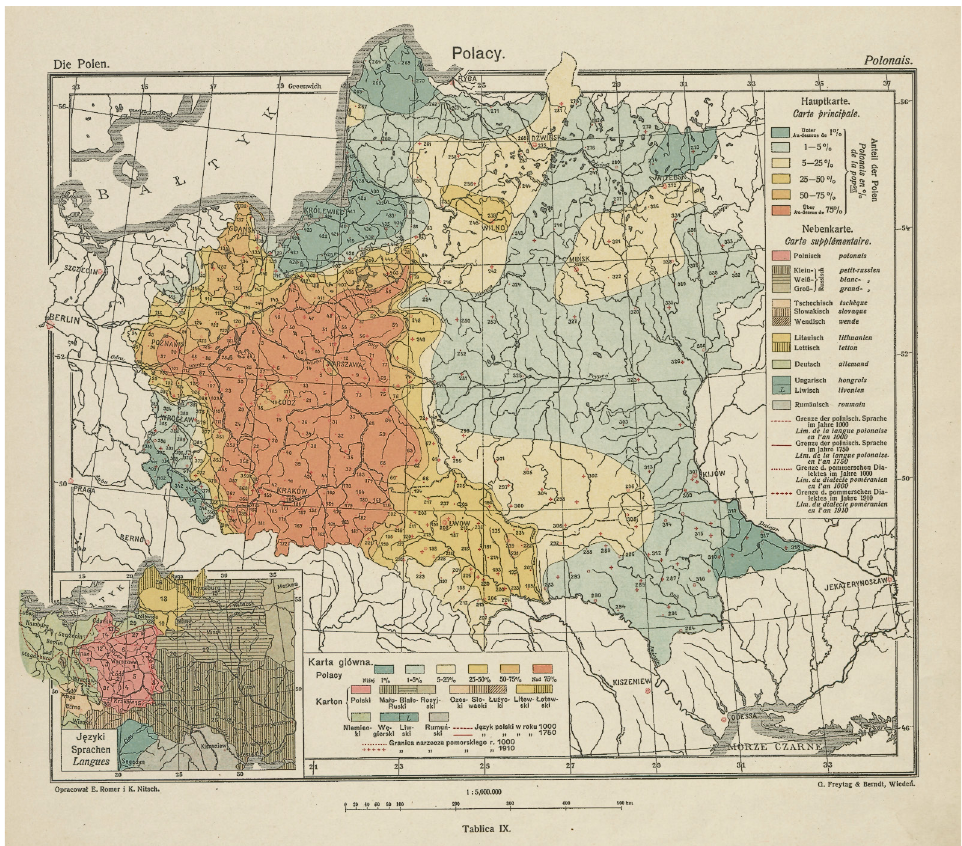
Fig. 3. Table IX. Polacy